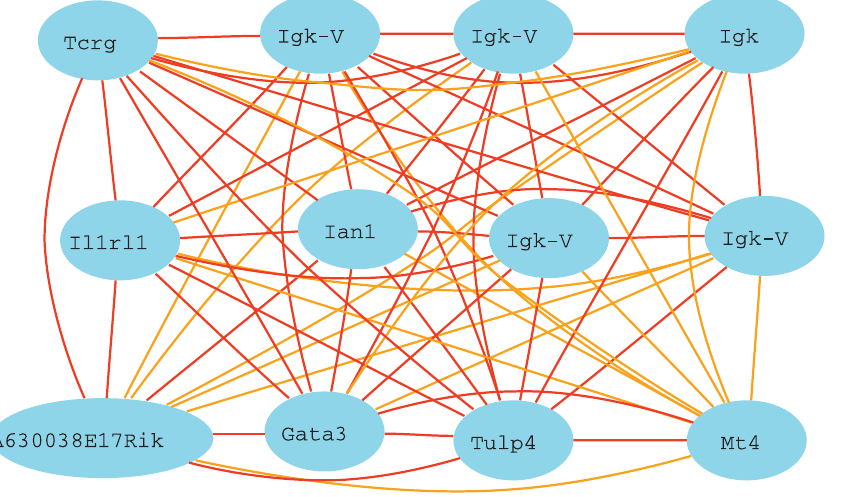
Figure 6. Genes Co-Expressed with Tulp4 in HSCs Gene expression data from HSCs [43] were used in WebQTL (webqtl.org) to identify genes most highly correlated with Tulp4 . The majority of genes encode proteins involved in immune function (e.g., immunoglobulins). DOI: